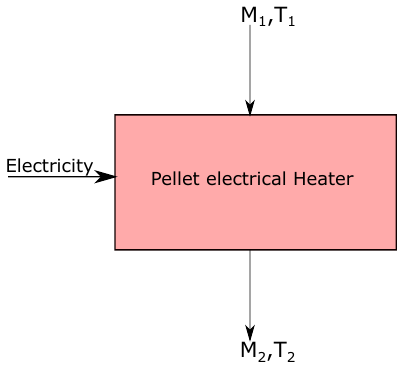
Figure 3. Mass and energy flows through the pellet heating